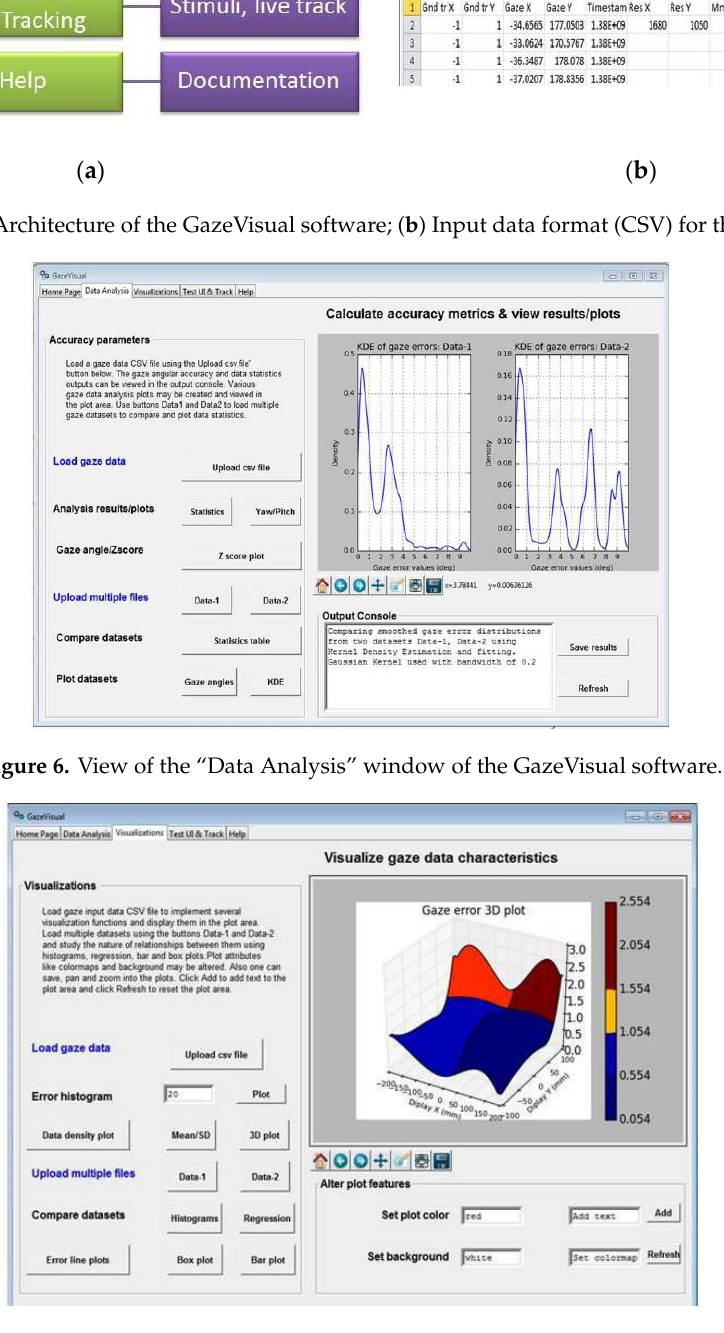
Figure 7. View of the “Visualizations” window of the GazeVisual software.